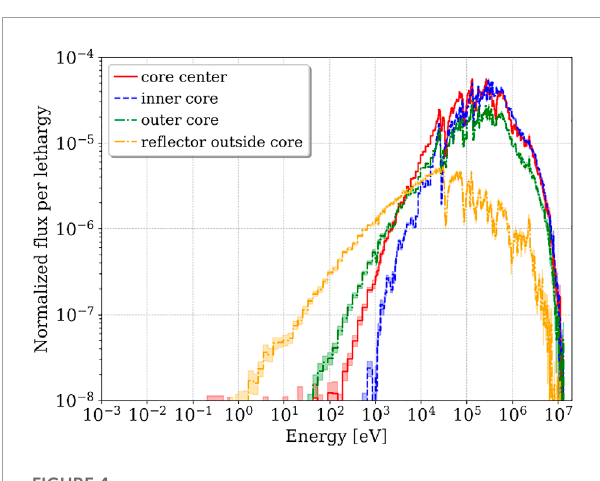
FIGURE 4 Normalized neutron flux of the INL Design A HPR at the core axial midline, at different radial